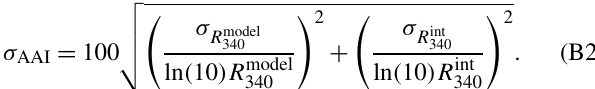
assume that the measurement noise of (cid:48) was normally